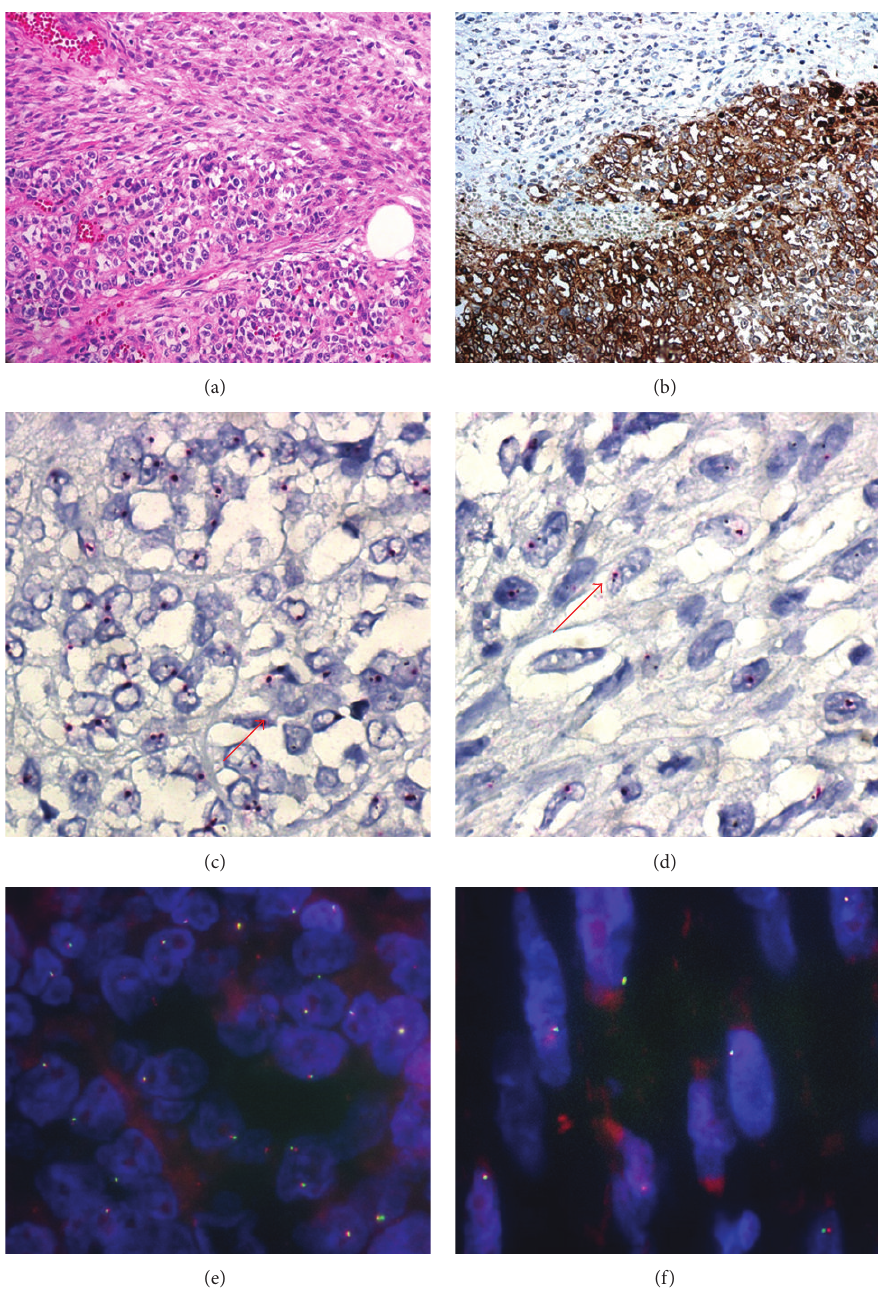
Figure 2: Retrospective screening of the phyllodes tumor revealed focal epithelium-like areas within the stroma composed of pleomorphic cells (panel (a), lower part of the image) that strongly expressed CD61 (panel (b)) and which were sharply demarcated from the conventional spindle cell component of the tumor (upper part of panels (a) and (b)). Chromogenic in situ hybridization of centromere 17 (red nuclear signal, arrows) revealed monosomy 17 in both the epithelial (panel (c)) and the spindle cells (panel (d)) of the tumor. Also, fluorescent fusion probes flanking 13q14 showed only one copy per nucleus (panels (e) and (f)) in both tumor